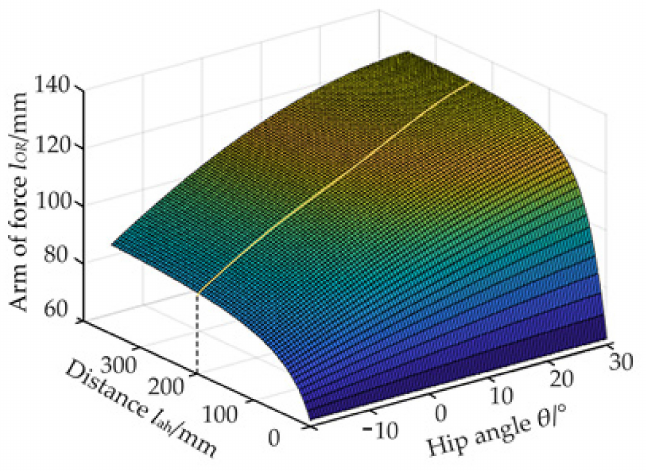
Figure A2. Auxiliary force arm in different states. When the distance l ah between the thigh anchor Q and the hip joint is more than 200 mm, the torque arm l oR corresponding to the same hip joint angle remains approxi- mately unchanged, and the curve of l oR arm is changed smoothly. Moreover, in order to improve the servo performance of the wire rope during the assisting process, the length of l a h should not be too large and the thigh anchor Q is fixed 200 mm below the hip joint. Hence, the waist anchor P is fixed at 50 mm above the hip joint and the thigh anchor Q at 200 mm below the hip